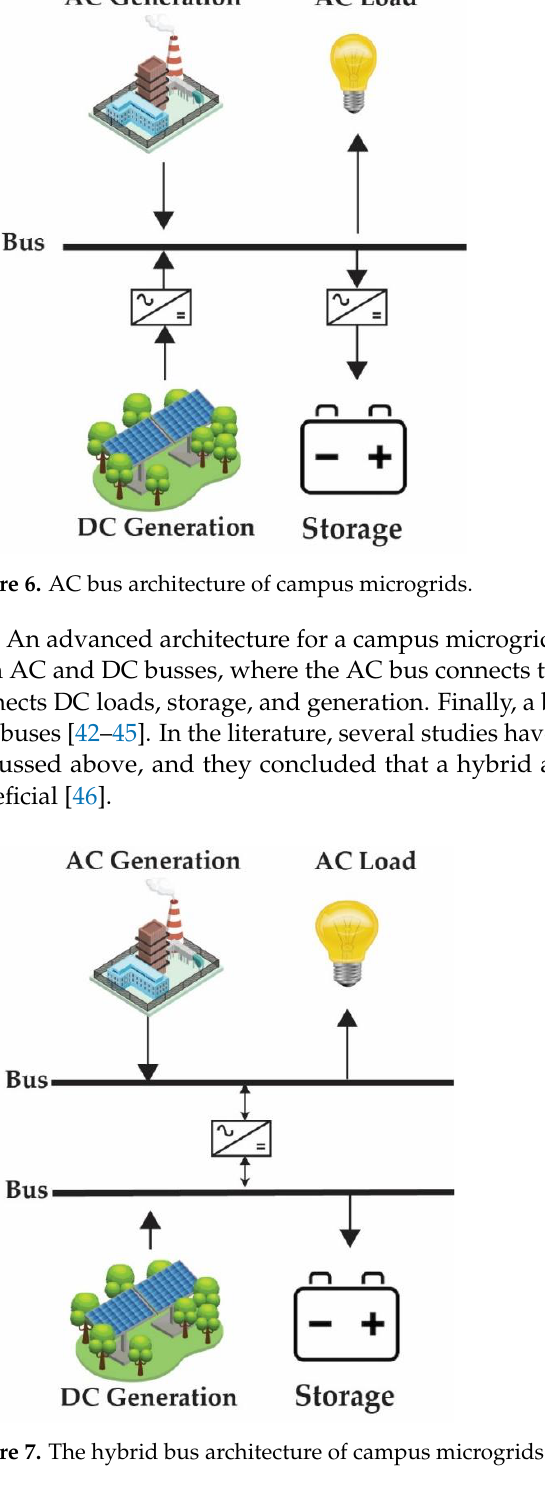
Figure 5. DC bus architecture of campus microgrids.